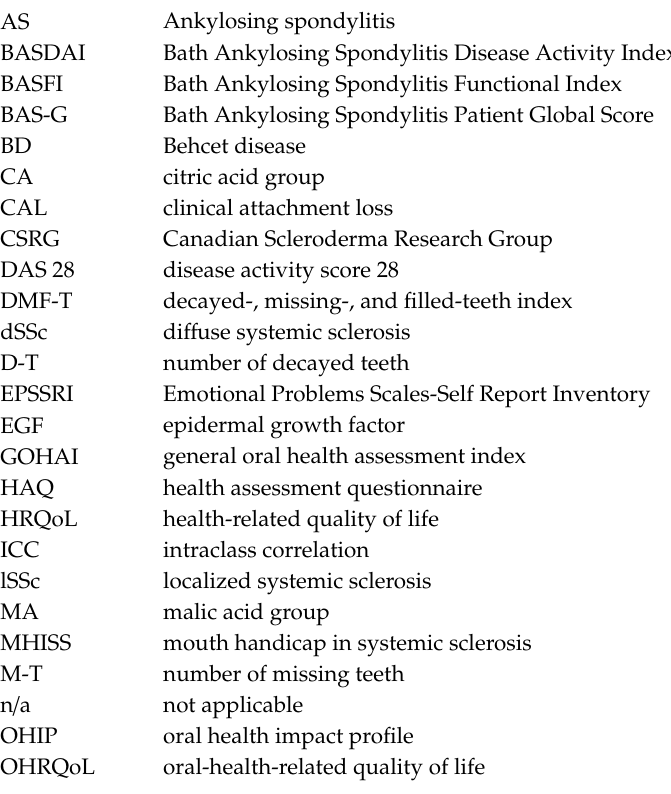
Table S1: Excluded studies during the evaluation process with reasons for exclusion, Table S2. Oral health parameters that were examined related to OHRQoL in the included